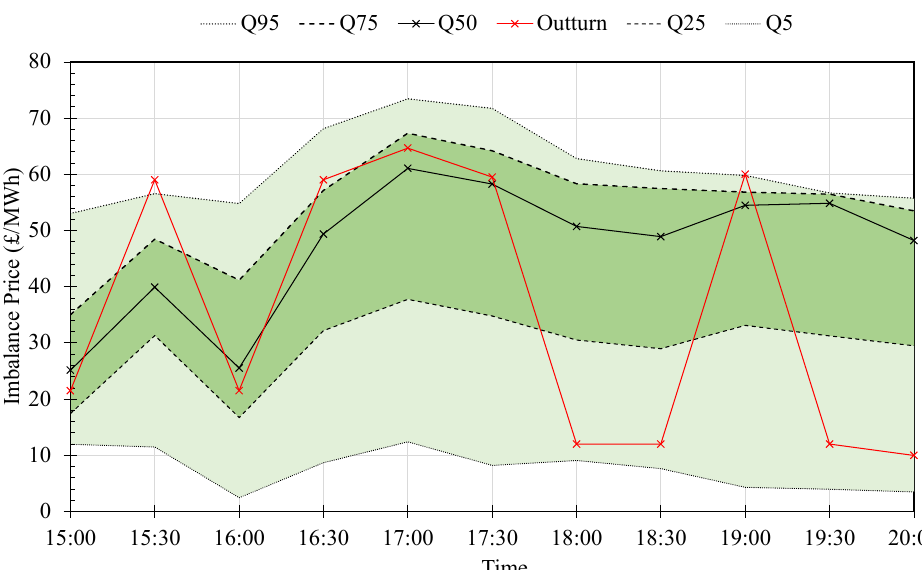
Figure 1. Example intraday probabilistic forecast of the imbalance price as a fan plot with 5%, 25%, 50%, 75%, and 95% quantiles and actual (out-turn) price issued on 11 November 2020 at